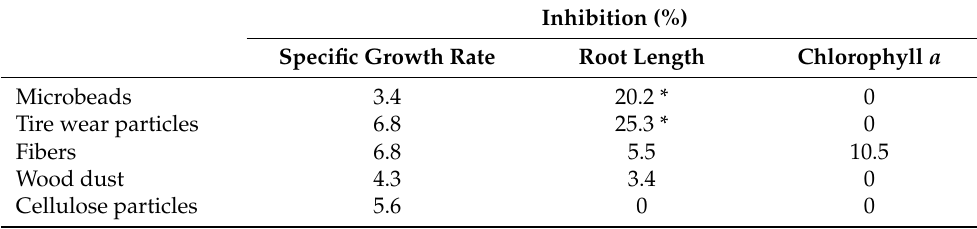
Table 2. Inhibition of specific growth rate, root length, and chlorophyll a content after expo- sure to microplastics (microbeads, tire wear particles, fibers) and natural particles (wood dust, cellulose